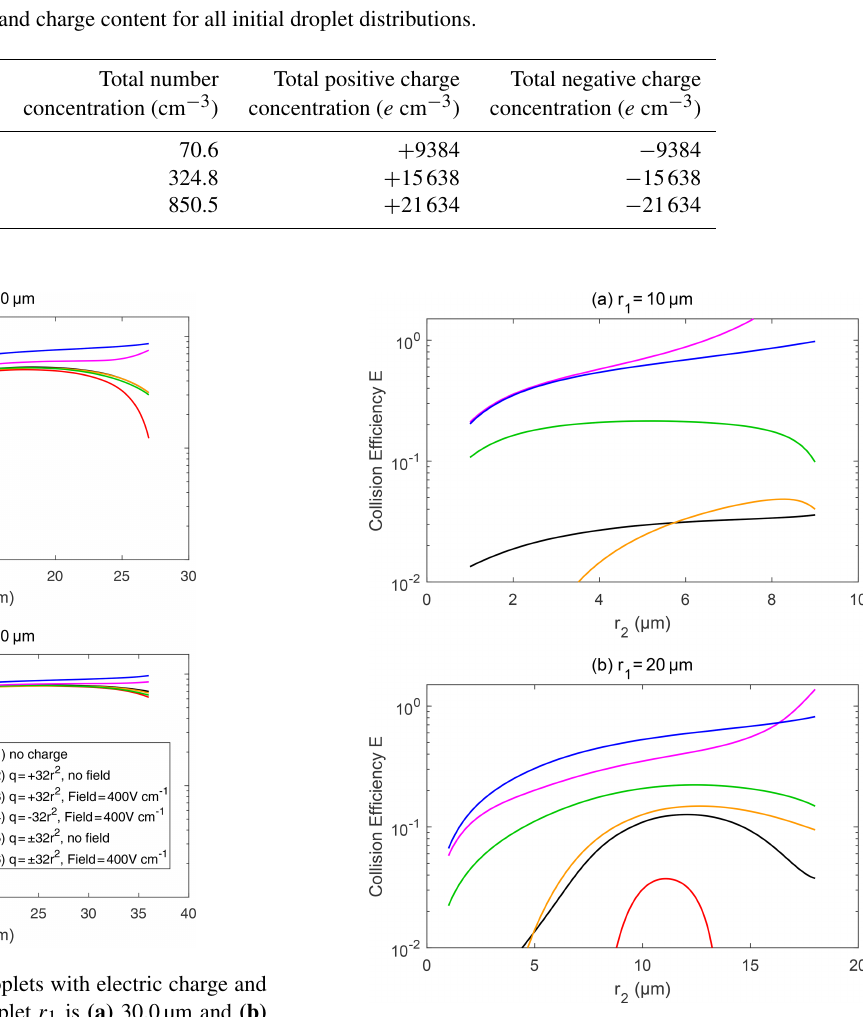
Figure 8. Collision efficiency for droplets with electric charge and field. The radius of the collector droplet r 1 is (a) 10.0µm and (b) 20.0µm. The other characteristics of the droplet pairs are similar to those in Fig.